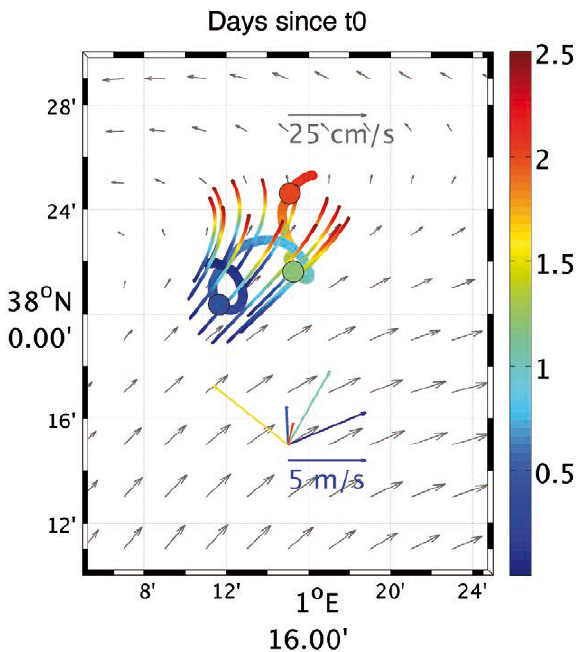
Fig . 5. – Drift trajectories and age-dependent larval spatial distribu- tions. Crosses indicate stations sampled. Coloured dots over sam- Fig . 4. – Buoy trajectory. Trajectory of the buoy indicated by the pled stations indicate mean age of bluefin tuna larvae in days as thick coloured curve. Colour bar indicates the time elapsed since indicated by the colour bar. Bluefin tuna densities (in ind/100 m 3 ) the buoy was released, in days. Coloured dots indicate the position are indicated by the dot size. Thin coloured curves indicate the drift of the buoy after 0.5 T, 1.5 T and 2.5 T, with T being the inertial trajectories of ideal passive drifters released over the mixed layer at oscillation period (19 hours). Thin coloured curves indicate the drift a distance of 2.5 nmi around the initial position of the Lagrangian patterns of the passive drifters released over the mixed layer at a buoy. Colours of the curves indicate the time elapsed since they distance of 1.5 nmi around the Lagrangian buoy. The coloured ar- were released in days, as indicated by the colour bar. Open circles rows at the bottom of the figure indicate local wind 10 m above the indicate the two cage positions at days 0, 1 and 2. Grey arrows indi- surface, reanalysed by the HIRLAM model, for days 0, 0.5, 1, 1.5 cate the geostrophic currents. The black stars indicate the positions and 2. The grey arrows indicate the deduced geostrophic currents of the used to compute the passive drifts.